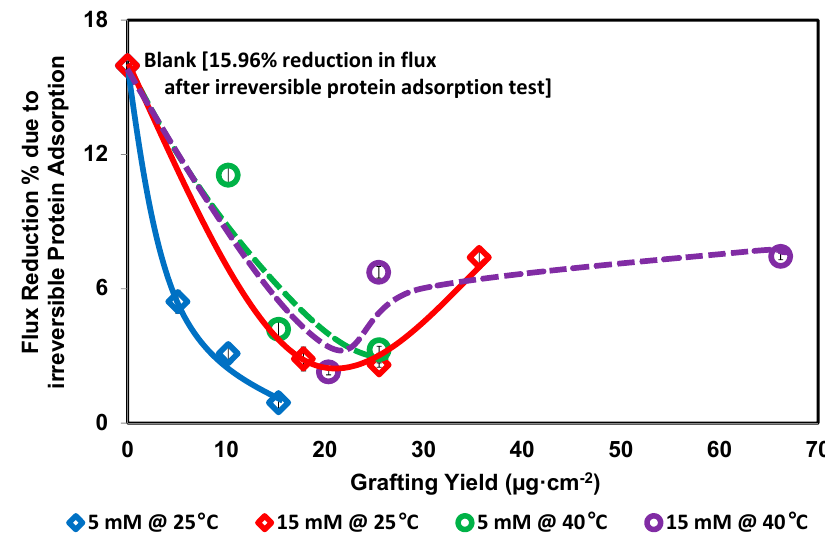
Figure 7. Flux reduction percent due to the irreversible protein adsorption at different grafting yield. Common reaction condition is pH 5.5 (0.1 M sodium acetate buffer), and 0.5 U · mL − 1 enzyme (laccase). Reaction at 25 ◦ C using 5 mM 2-AP (blue diamond) and 15 mM 2-AP (red diamond), and reaction at 40 ◦ C using 5 mM 2-AP (green circle) and 15 mM 2-AP (purple circle). Resection times 30, 60, and 120 min were tested and the grafting yield was increased with increasing the reaction time. The solid and dashed lines are guides for general trend for the studied conditions.